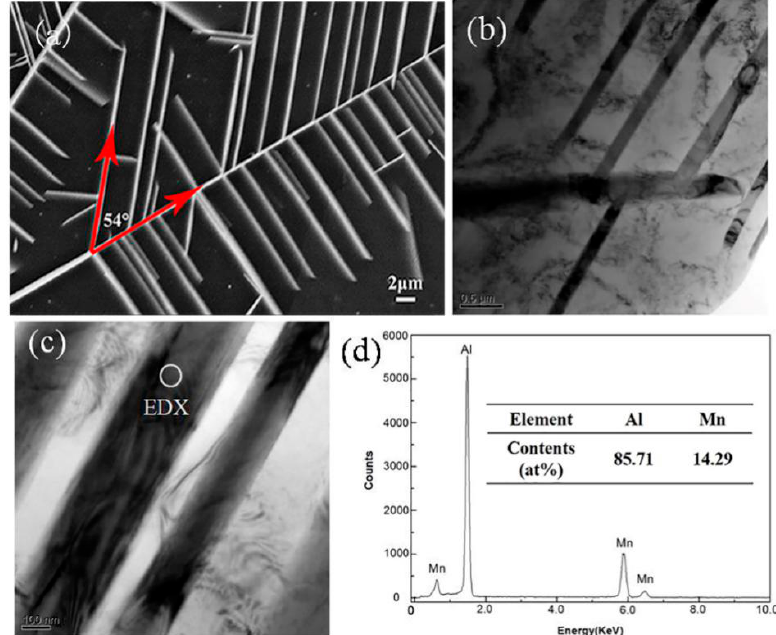
Figure 6. Dendrite microstructure of the cross-section of the cylindrical sample in suction casting Al–6 wt.% Mn alloys: ( a ) SEM BSE; ( b , c ) TEM BF (bright field); ( d ) TEM EDS.